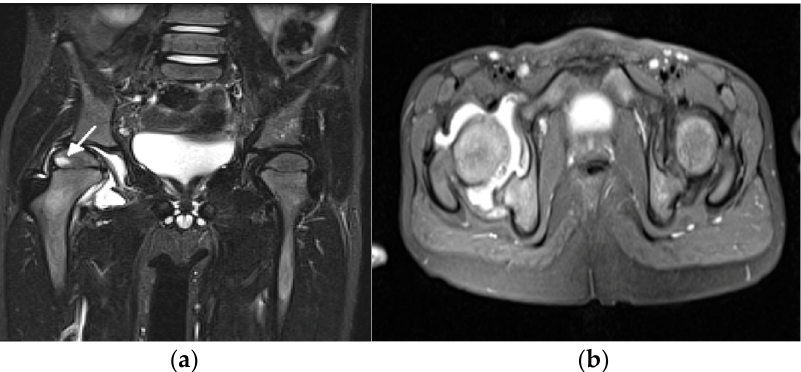
Figure 4. A 5-year-old girl with juvenile idiopathic arthritis with hip involvement. Coronal short tau inversion recovery (STIR) ( a ) and axial proton density (PD)-weighted fat saturated ( b ) MR images show right hip effusion and bone marrow edema in the right femoral epiphysis (arrow).